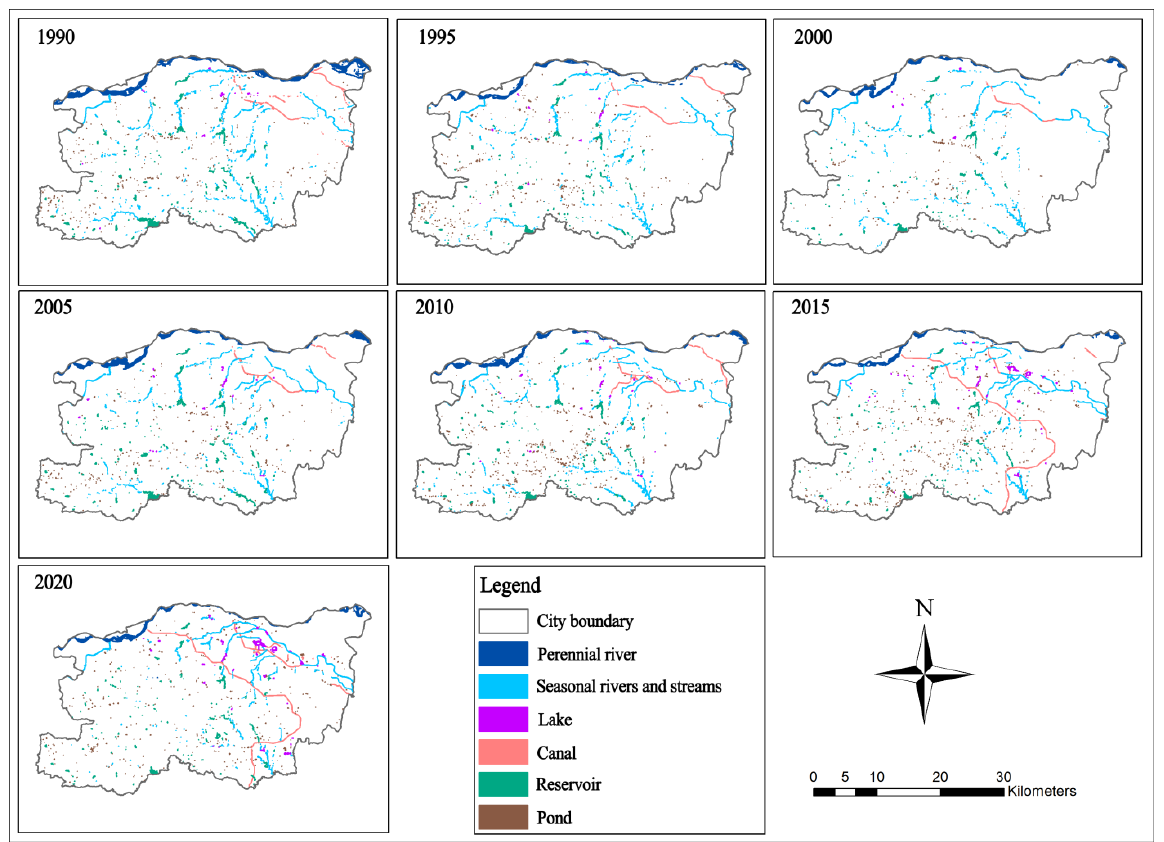
Figure 4. The distribution of urban waterbodies in Zhengzhou from 1990 to 2020. Note the additions in 2015 of two large lakes in the northeast of the city and the canal that runs from northwest to southeast.